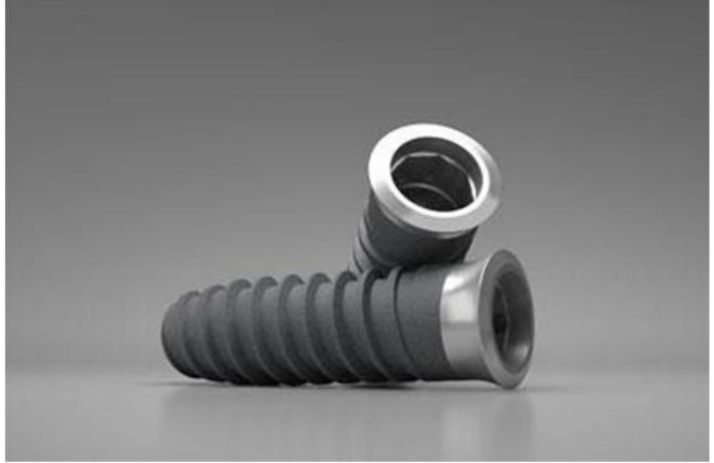
Figure 6. Dental implant studied. This implant was manufactured from grade 4